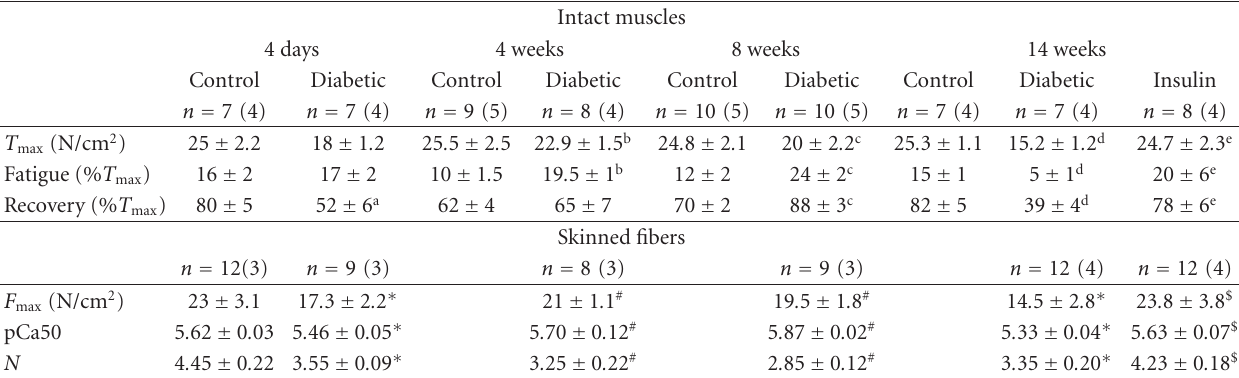
Table 1: Contractile data from diaphragm of diabetic animals and age-matched controls. Intact muscles 4 days 4 weeks 14 weeks Control Diabetic Control Diabetic Control Diabetic Control Diabetic